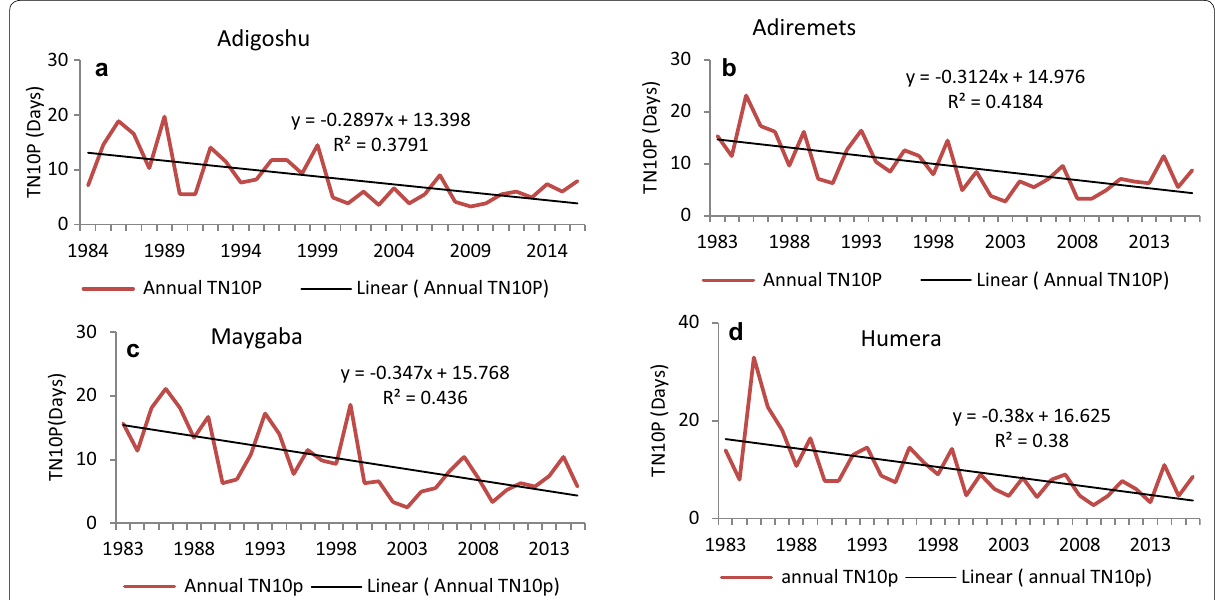
Fig. 6 Annual cool nights (TN10P) of different stations at a Adigoshu, b Adiremets, c Maygaba, and d Humera